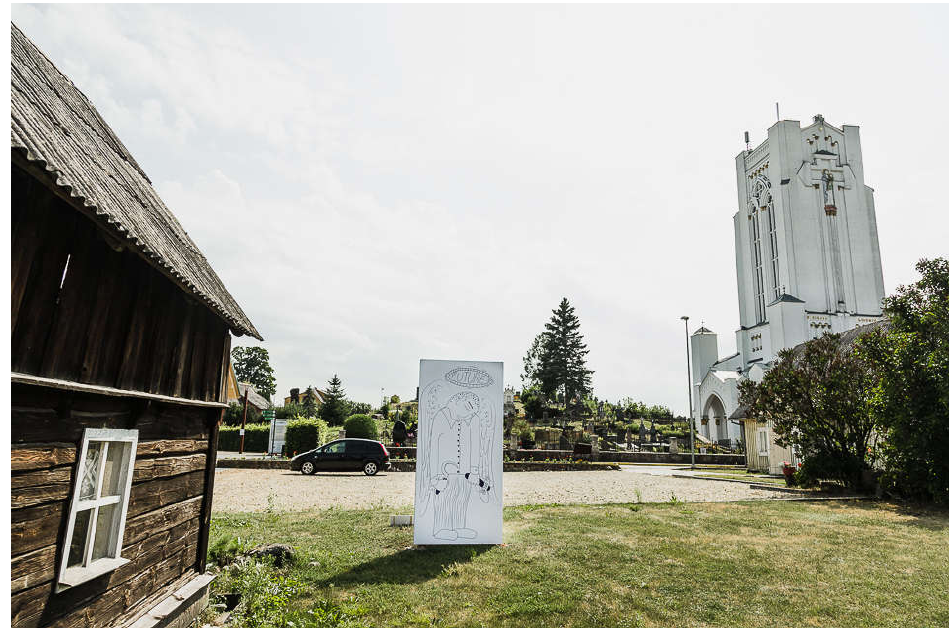
Figure 9. Artwork made during the art biennial near the religious center of Šiluva.